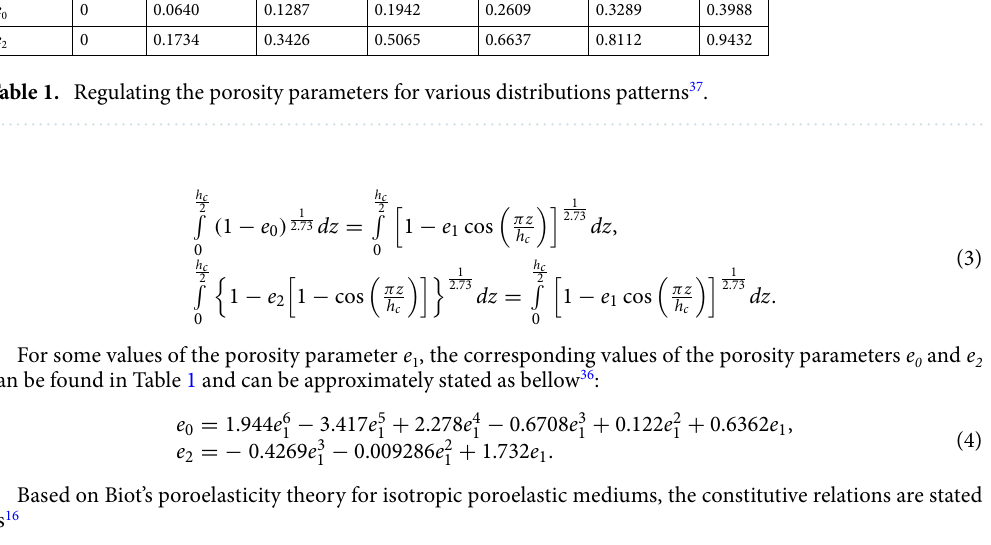
Based on Biot’s poroelasticity theory for isotropic poroelastic mediums, the constitutive relations are stated as 16